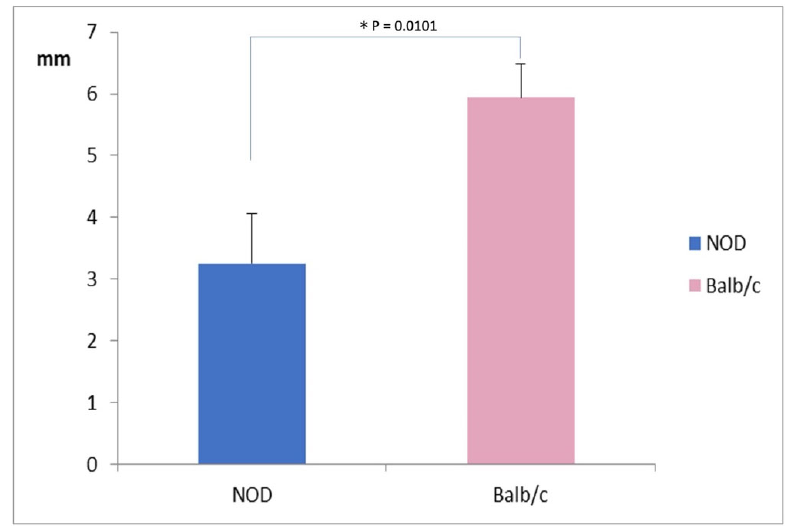
Figure 1. Comparison of Strip Meniscometry Tube values between the NOD and the Balb/c mice. Note the significantly lower SMT value in NOD mice compared to the WT mouse ( p = 0.00101). * represents p < 0.05.